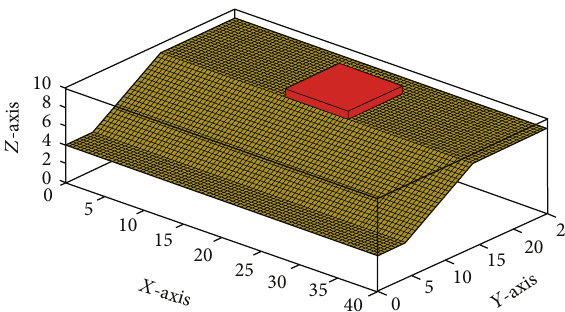
Figure 17: Generated 3D models of example problem 2 by the present